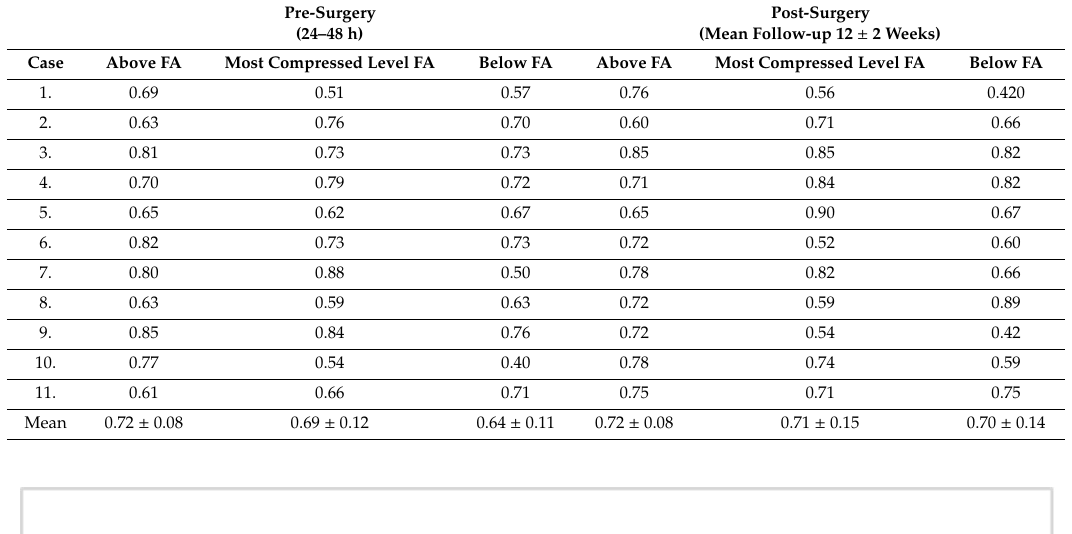
Table 3. FA values of the most compressed level (site of surgery) and the upper and lower level. The pathological FA value ( < 0.68 ± 0.05 [20]) is shown in red color.